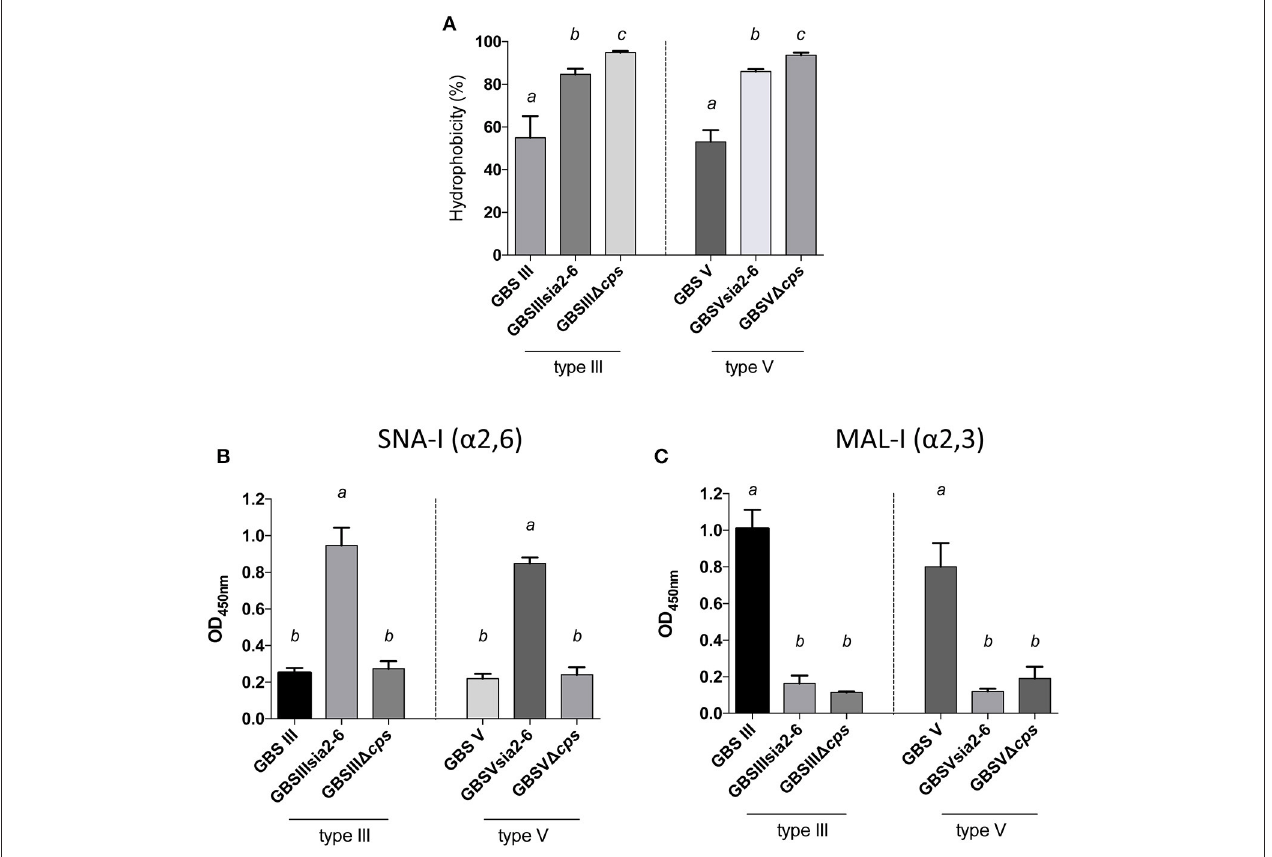
FIGURE 10 | Capsular polysaccharide (CPS) expression levels and sialic acid linkage in GBS type III and V mutants carrying exogenous α -2,6-sialyltransferase. (A) Hydrophobicity (%) of GBS type III and V wild-type strains and the mutants GBSIIIsia2,6 ( 1 cps3K / cps2N ) and GBSVsia2,6 ( 1 cps5K / cps2N ) carrying the S. suis α -2,6-sialyltransferase. The non-encapsulated mutant strains (GBSIII 1 cps and GBSV 1 cps ) were used as controls. (B,C) Whole-bacterial cell enzyme-linked lectin assay (ELLA) was performed to detect α -2,3 or α -2,6 capsular sialic acid linkage in these mutant strains. Whole bacteria were incubated with Sambucus nigra agglutinin (SNA-I) specific for Neu5Ac α -2,6 linkages, or Maackia amurensis leukoagglutinin (MAL-I) specific for Neu5Ac α -2,3 linkages. The non-encapsulated mutants were used as negative controls. Data in (A–C) are expressed as mean ± SEM of at least three independent experiments. Student’s t -test analyses